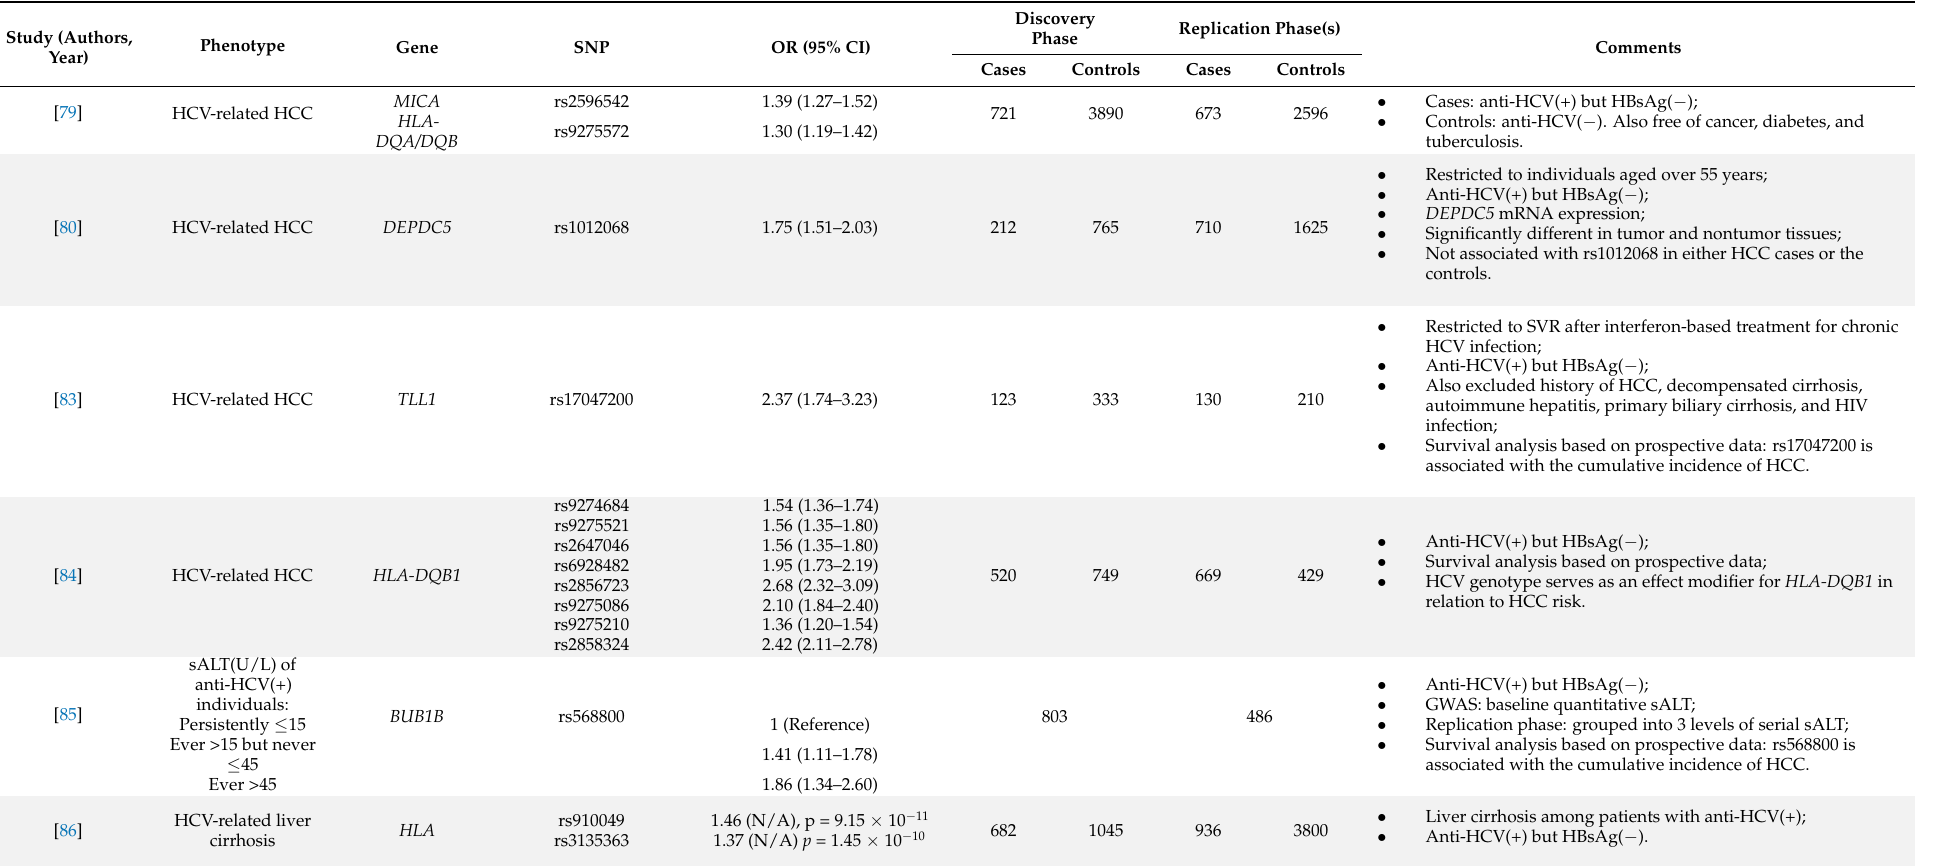
Table 3. GWASs that Identified SNPs Associated With Susceptibility to HCV-Related HCC or Liver